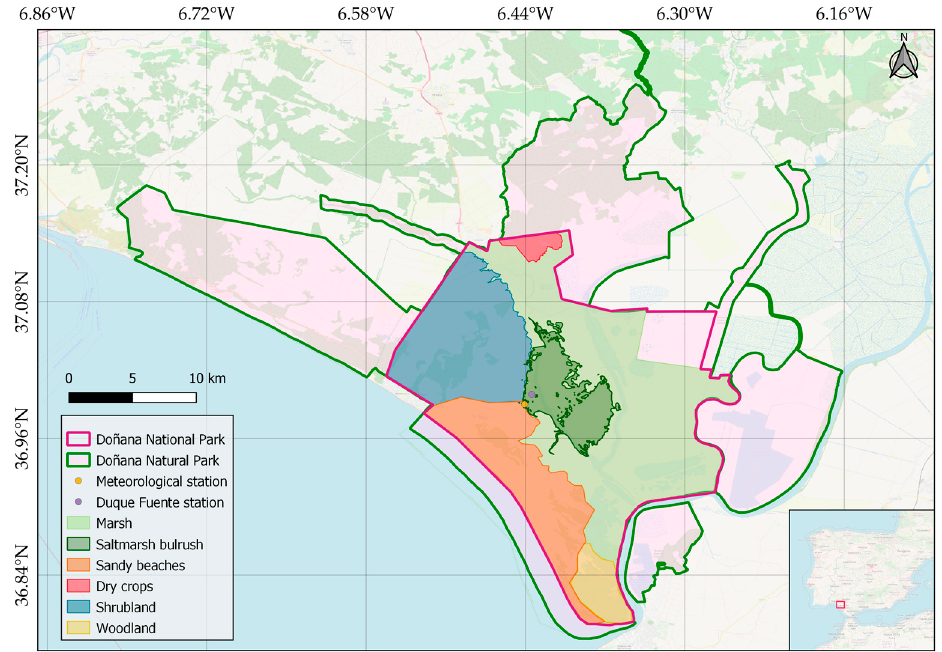
Figure 1. Protected area limits of Doñana Natural Park and Doñana National Park located in the southwest of Spain, and the distribution of its major habitats.